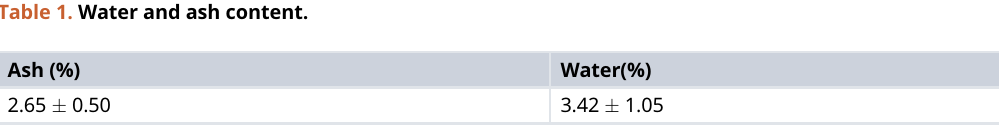
Table 1. Water and ash